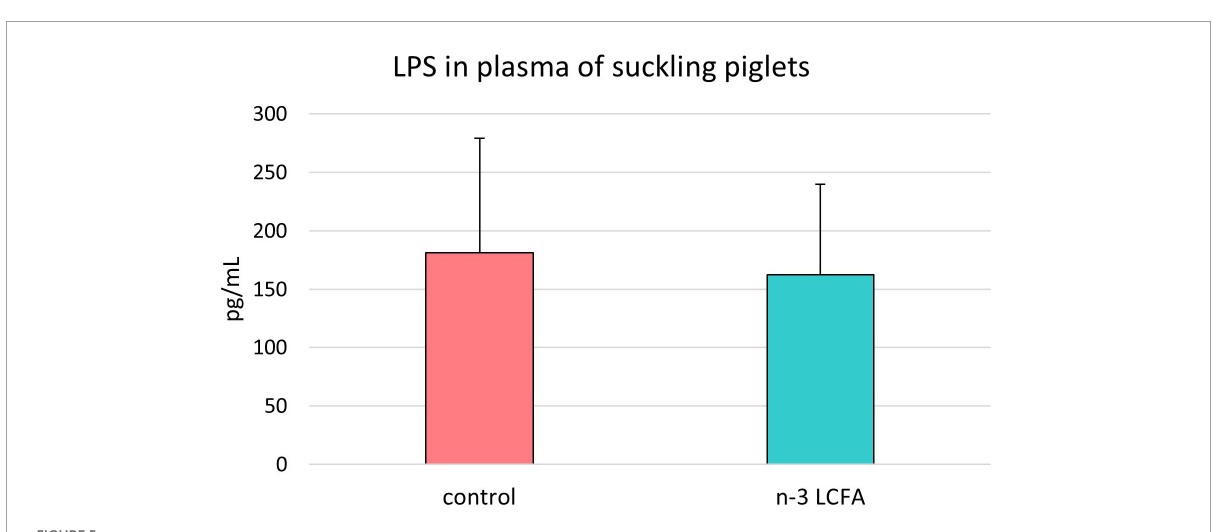
FIGURE5 Lipopolysaccharide (LPS) concentration in plasma of suckling piglets from control and n-3 LCFA-fed sows. n = 44 for control and n = 40 for n-3 LCFA. LCFA, long-chain fatty